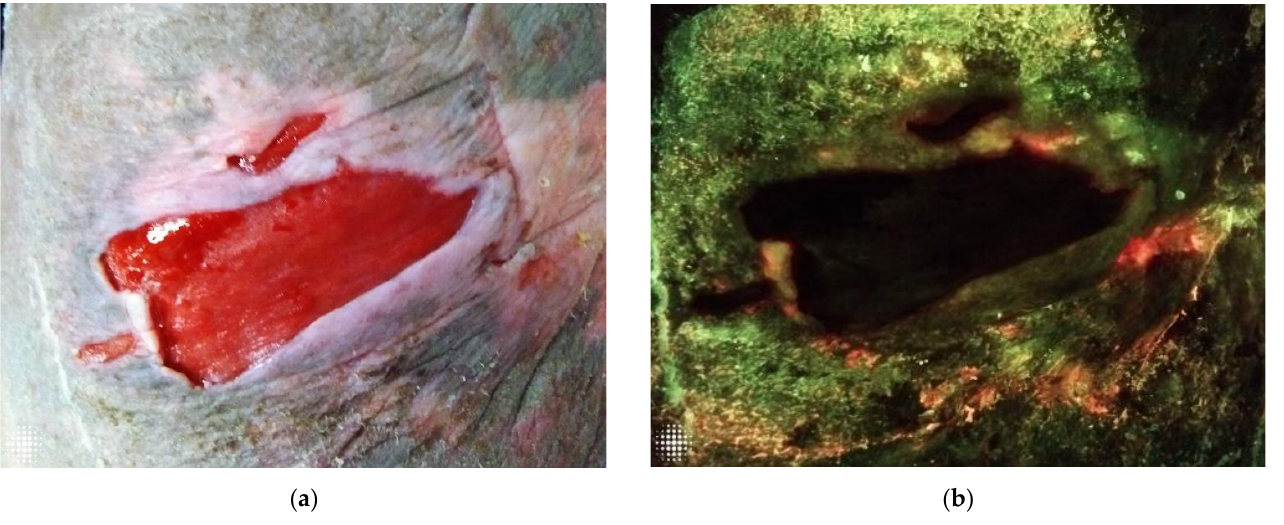
Figure 3. ( a ). Standard image of a wound without any obvious clinical signs and symptoms of infection on physical examination. ( b ) The same wound assessed under FL-imaging, demonstrating a red positive signal, indicative of high bacterial loads in the peri-wound area.